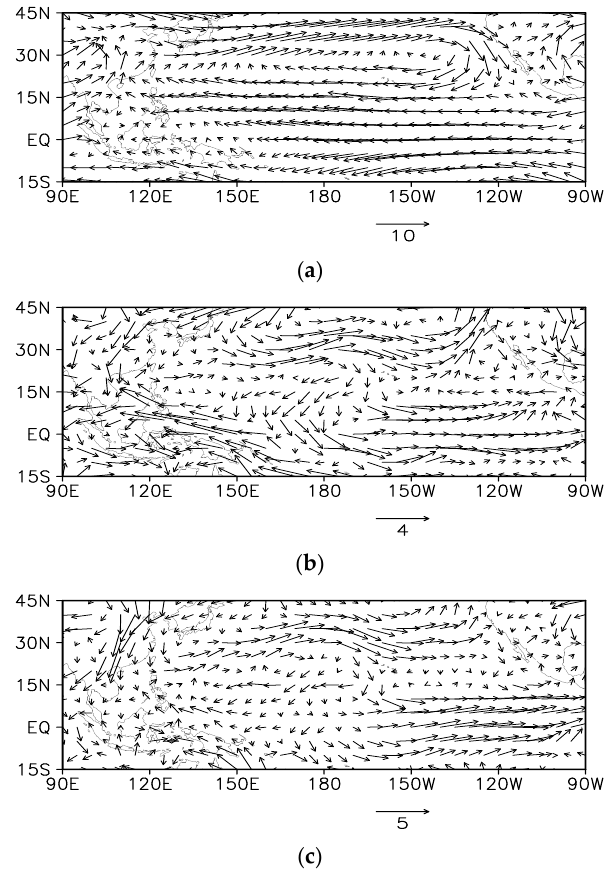
Figure 9. The wind at 850hPa averaged from April to June ( a ), the wind difference between the warm years during 1991 to 2008 and the warm years during 1958 to 1980 ( b ), and the wind difference between the cold years during 1991 to 2008 and the cold years during 1958 to 1980 ( c ) (unit: m·s −1 ).